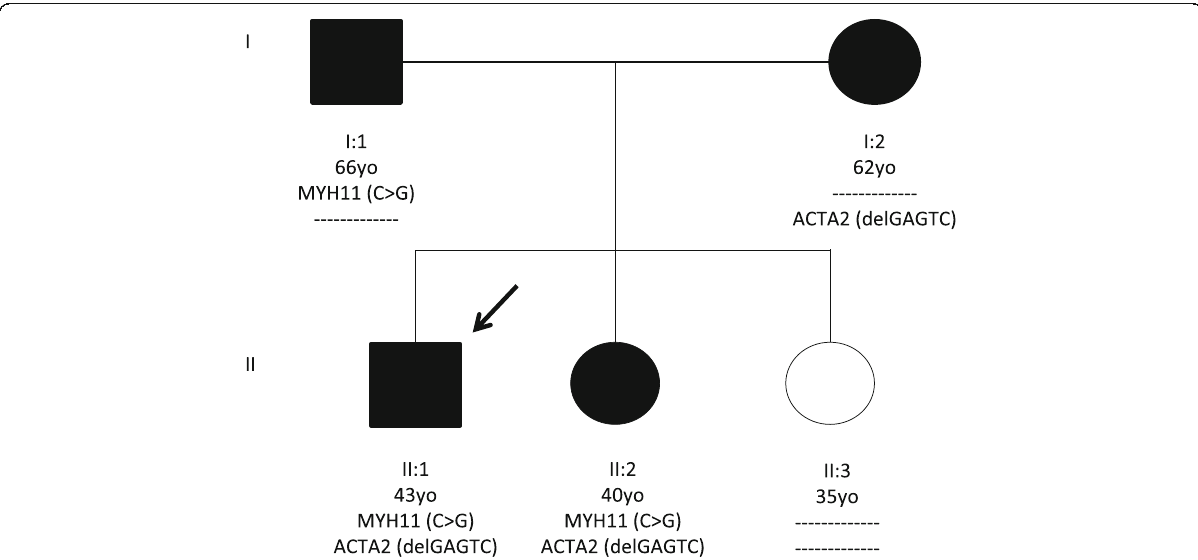
Fig. 1 Pedigree of the family with c.3234C > G, p.Ile1078Met variant in MYH11 gene and c.363_367del GAGTC, p.Met121Ilefs*5 variant in ACTA2 gene. The individual II:2 on initial screening had normal aortic measurements and after genetic screening was re-evaluated and found to have a mild dilation. Proband is indicated with an arrow; Black-filled symbols represent affected individuals with TAA; Age of the family members and their genotypes are listed below the symbols; Dotted lines indicate the absence of the